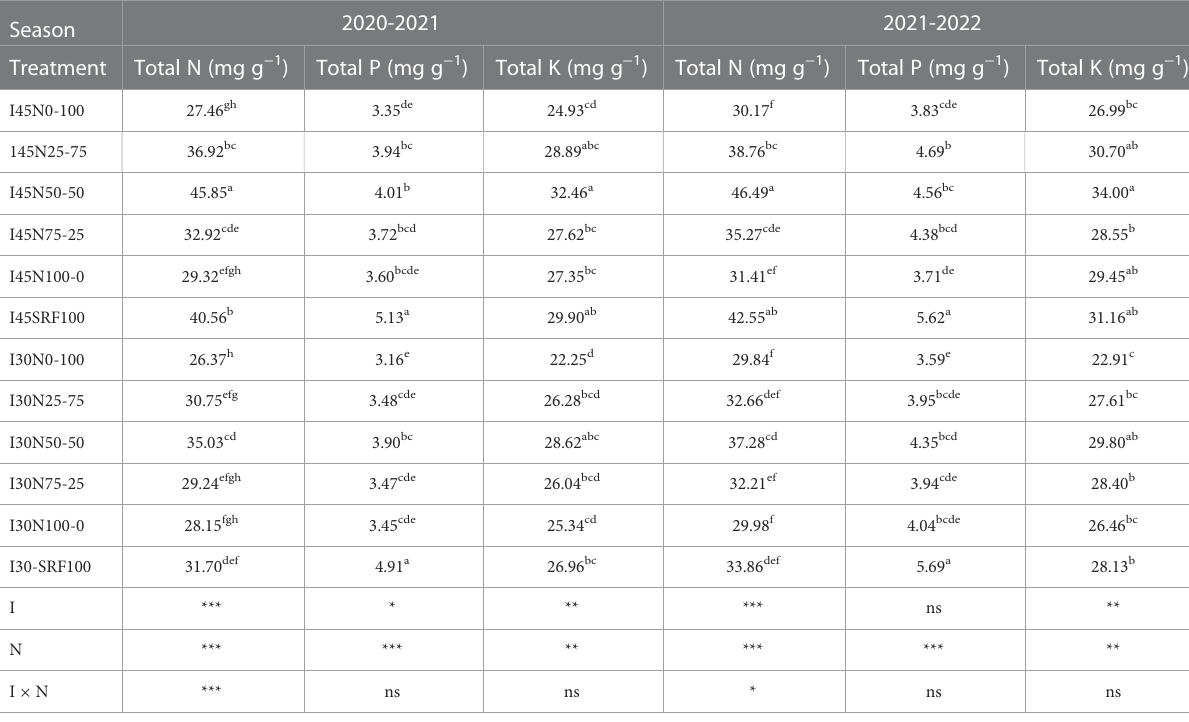
TABLE 7 Interactive effect of different irrigation scheduling and nitrogen application modes on winter wheat nutrient content during 2020-2021 and 2021-2022 growing seasons.